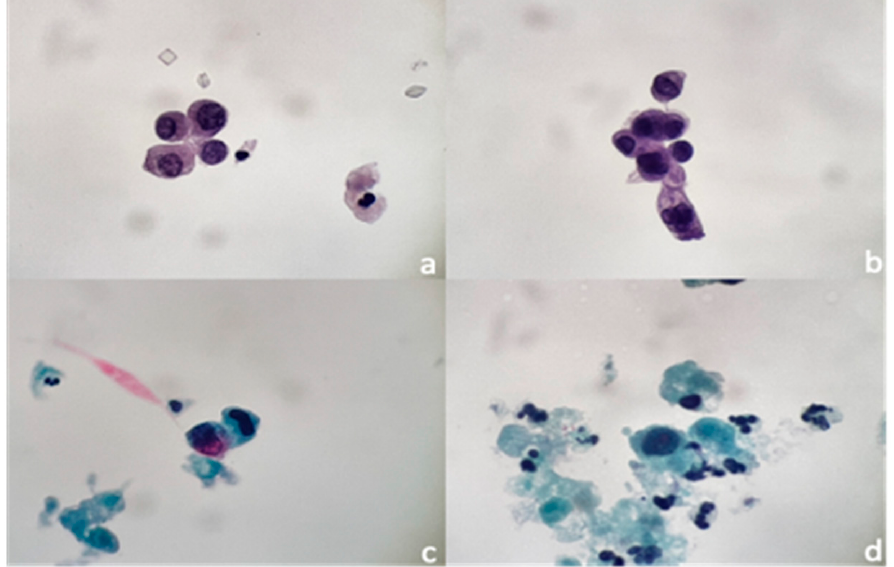
Figure 2. Cytological findings in cases under follow-up for urothelial carcinoma. ( a ) Characteristic finding of atypia urothelial cell. Hyperchromatic nuclei and nuclei/cytoplasm loss. ( b ) Isolated group with evidence of cytologic atypia. Some cytoplasm has a vacuolated aspect with hyperchromatic nuclei. ( c ) Two isolated urothelial cells with marked cytologic atypia suspicious for carcinoma. ( d ) Single urothelial cell with marked loss of nucleus − cytoplasm ratio, nuclear hyperchromatism, and presence of nucleolus. (Papanicolau staining. DA 20× and 40×).